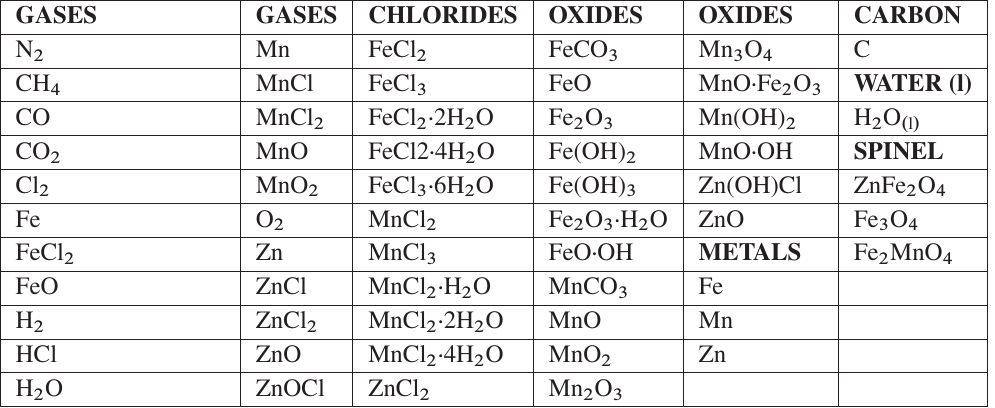
Table 2. Standard phases and species utilized in the equilibrium calculations.